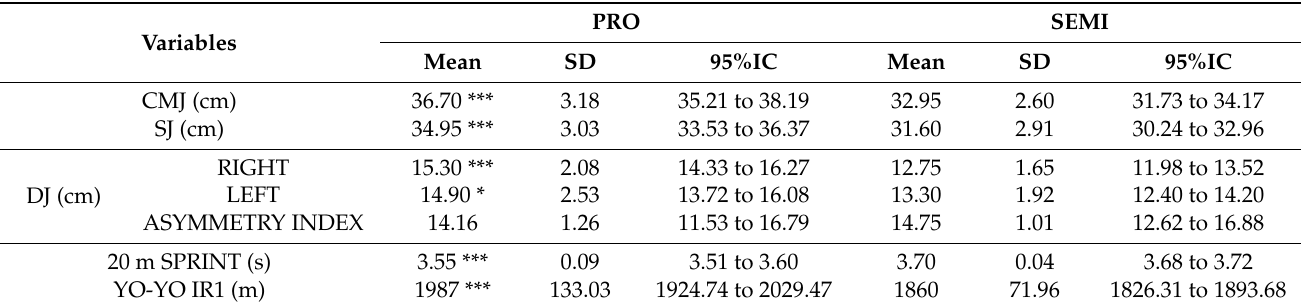
Table 5. Jump, sprint and Yo-Yo intermittent recovery test level 1 performances determined for professional and semi- professional group.